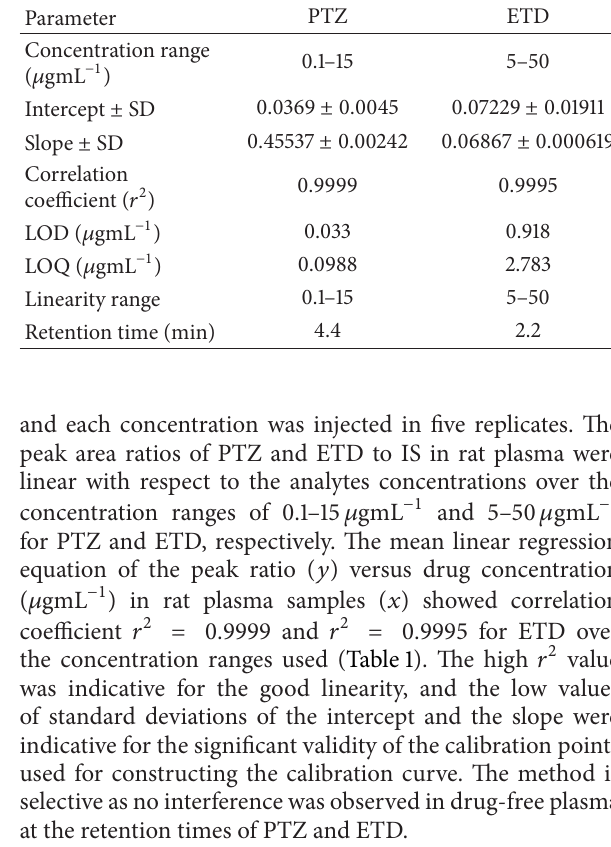
Table 1: Analytical parameters for determination of PTZ and ETD via the proposed